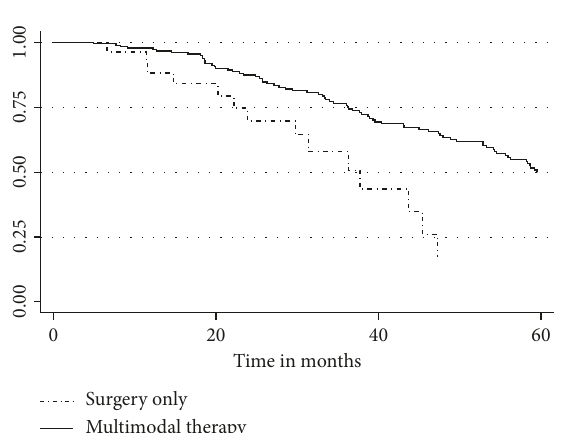
Figure 2: Kaplan–Meier overall survival for patients treated with surgery with and without chemotherapy regardless of radiotherapy